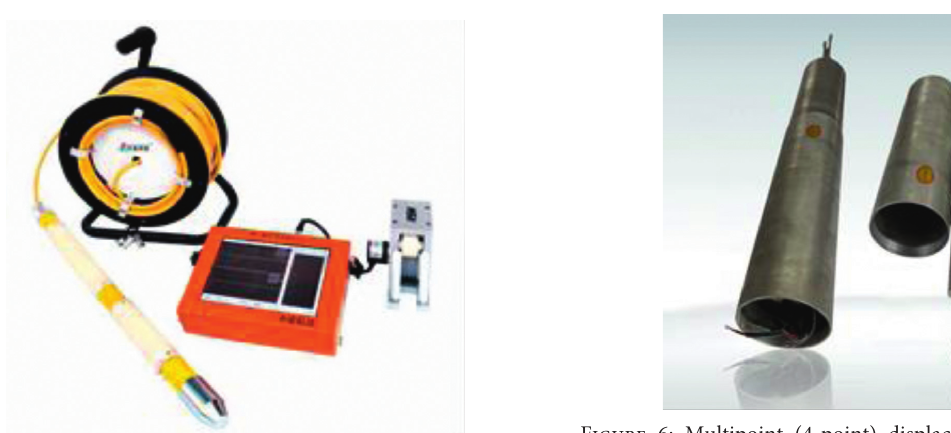
Figure 5: YL-LCT broken rock zone tester (Shanghai Y-Link Engineering and Technology Co., Ltd., China).